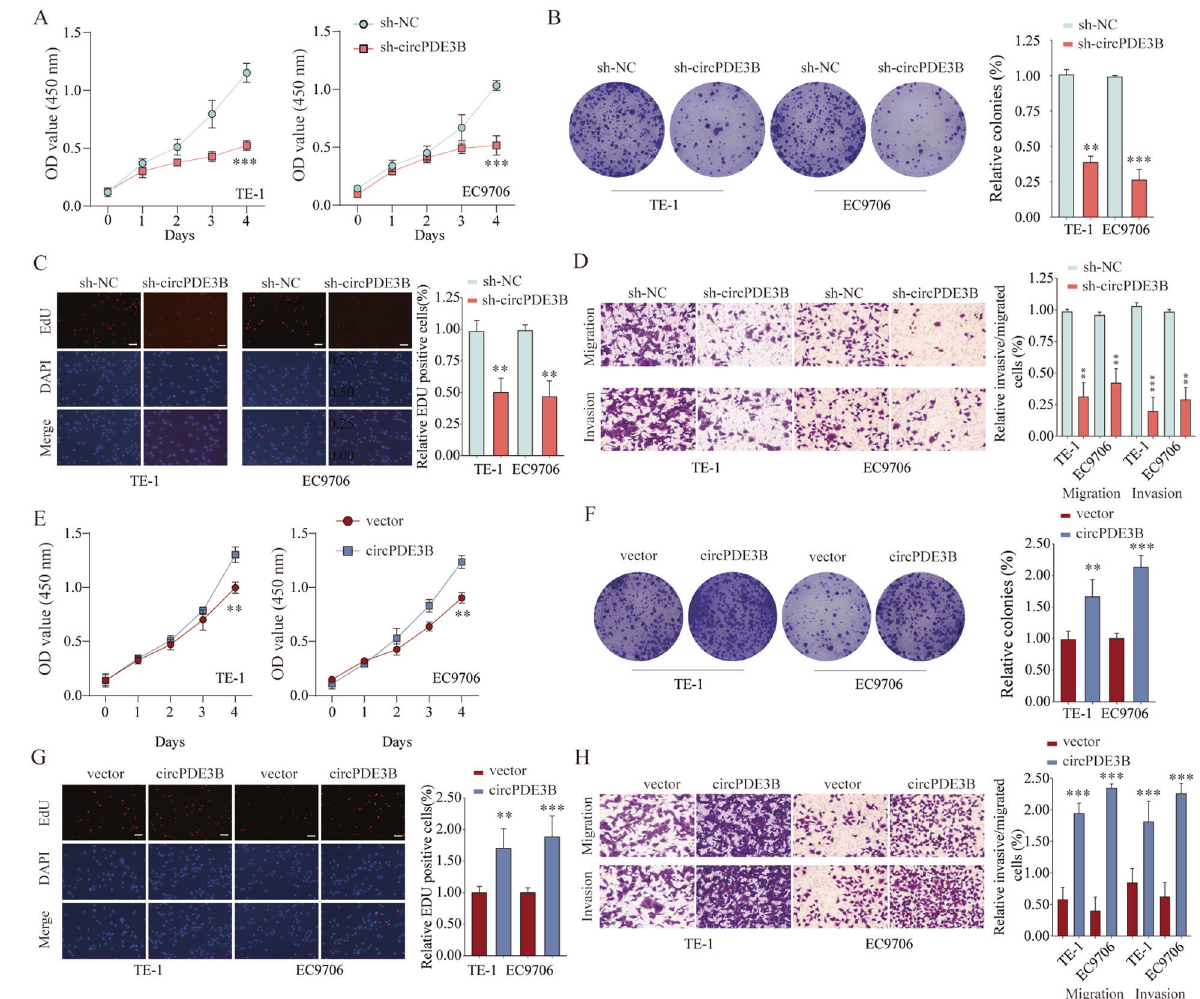
Fig. 3 circPDE3B promotes ESCC cell proliferation and invasion in vitro. A CCK-8 assay was used to detect cell viability of TE-1 and EC9706 cells after circPDE3B knocking down. B Colony formation assays were used to detect the clone ability of TE-1 and EC9706 cells after circPDE3B knocking down. C EdU assays were used to detect the DNA synthesis rate of TE-1 and EC9706 cells after circPDE3B knocking down. Scale bar: 50 μ m. D Transwell assays were used to detect cell migration and invasion capacities of TE-1 and EC9706 cells after circPDE3B knocking down. E CCK-8 assays were used to detect cell viability of TE-1 and EC9706 cells after enforced expression of circPDE3B. F Colony formation assays were used to detect the clone ability of TE-1 and EC9706 cells after enforced expression of circPDE3B. G EdU assays were used to detect the DNA synthesis rate of TE-1 and EC9706 cells after enforced expression of circPDE3B. Scale bar: 50 μ m. H Transwell assays were used to detect cell migration and invasion capacities of TE-1 and EC9706 cells after enforced expression of circPDE3B. * p < 0.05, ** p < 0.01, *** p <